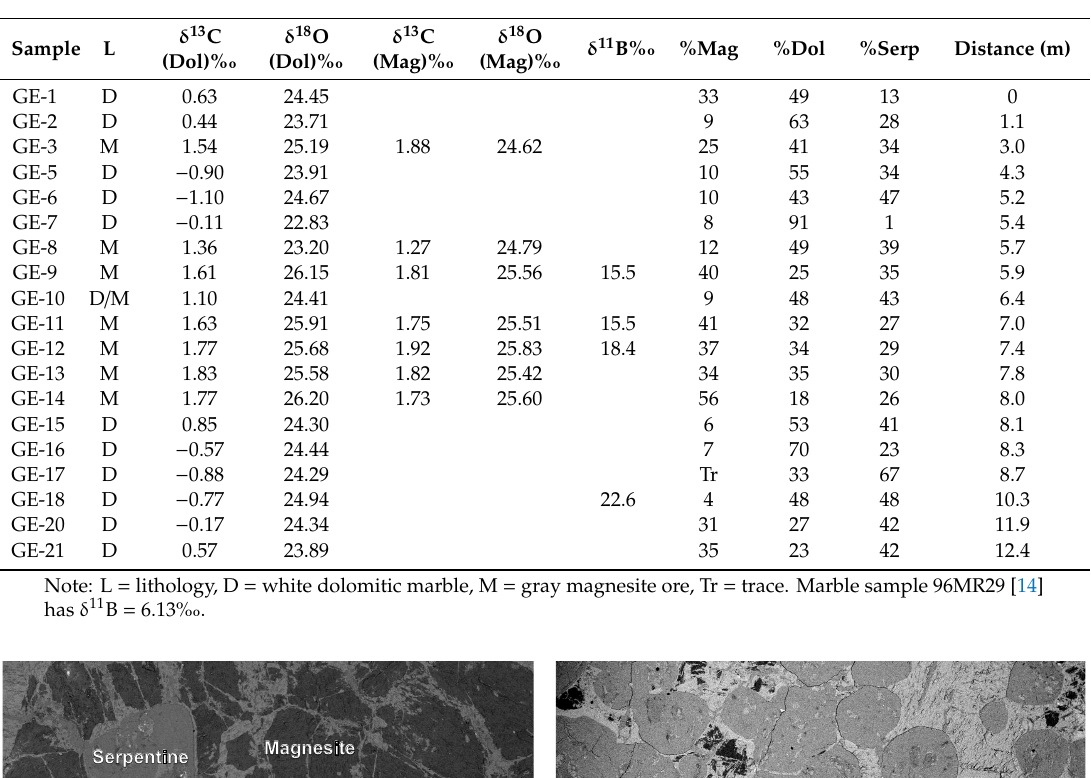
Table 1. Stable isotope data from the Dobbie mine, Kilmar magnesite district, Quebec.